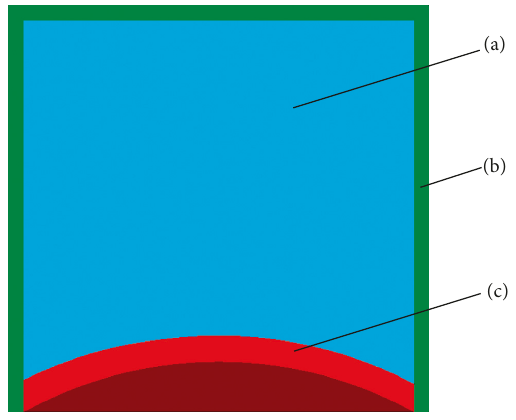
Figure 11: Finite element